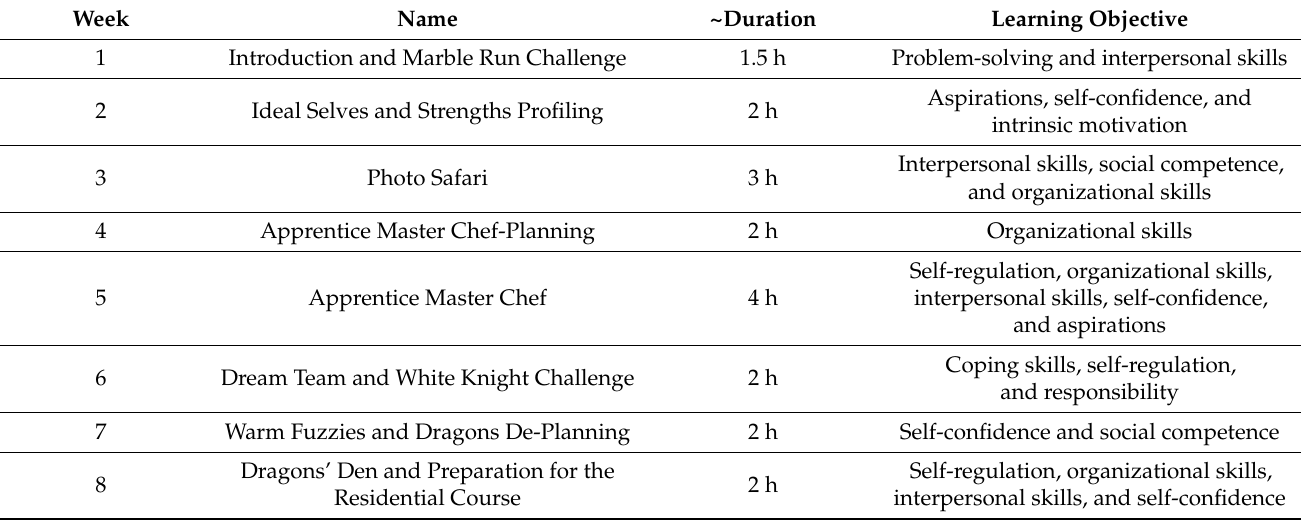
Table 1. MST4Life™ program content and learning